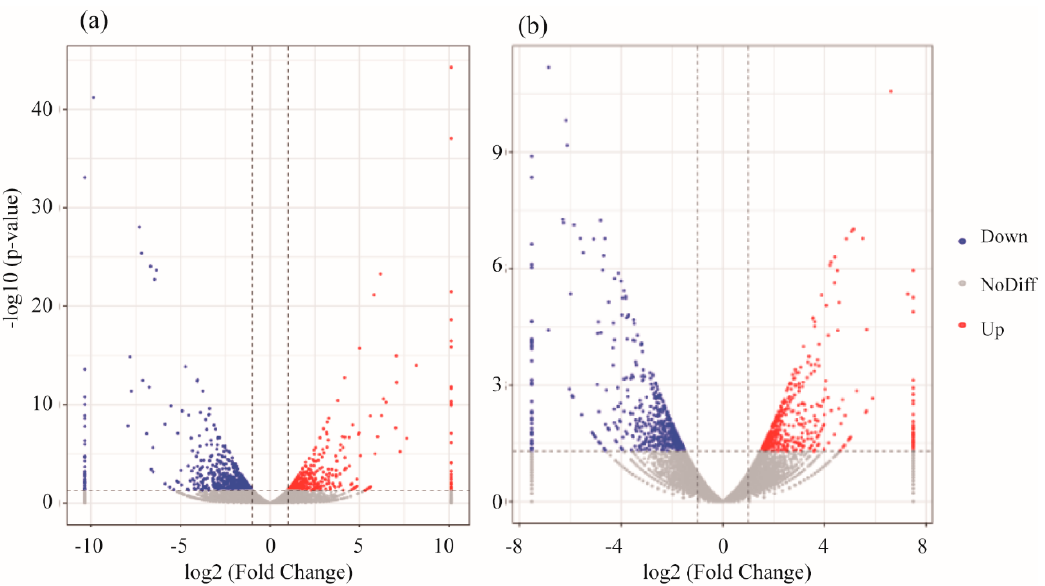
Figure 4. Volcano plots of the gene libraries of muscle from fish in the antibiotic-treated groups and control group showing the variance in gene expression with respect to FC and FDR. Each dot represents an individual gene: the black dots on the left represent the downregulated genes, and the red dots on the right represent the upregulated genes ( a ) D. rerio , ( b ) O. latipes .